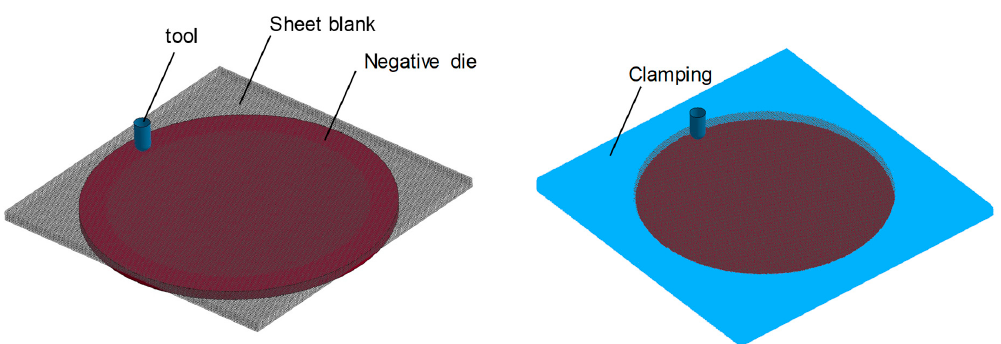
Figure 9. Model set-up for the disc spring manufacturing simulation.